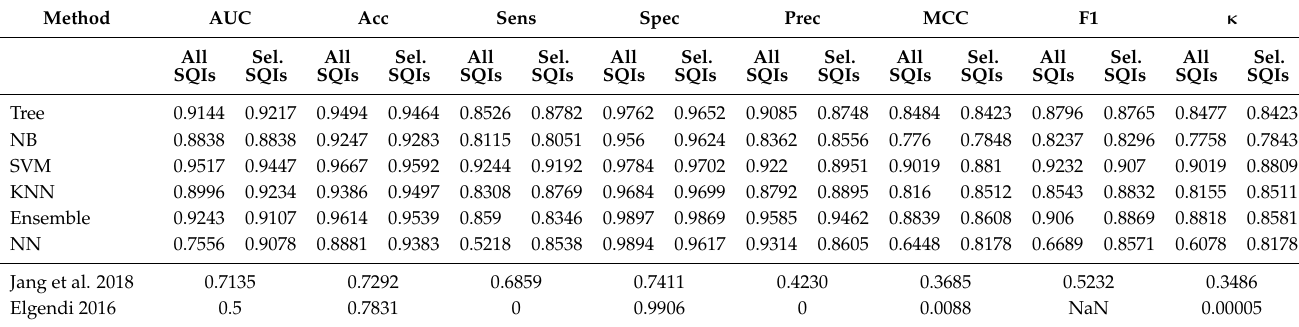
Table 5. Performances for Type 1 High-quality classifiers